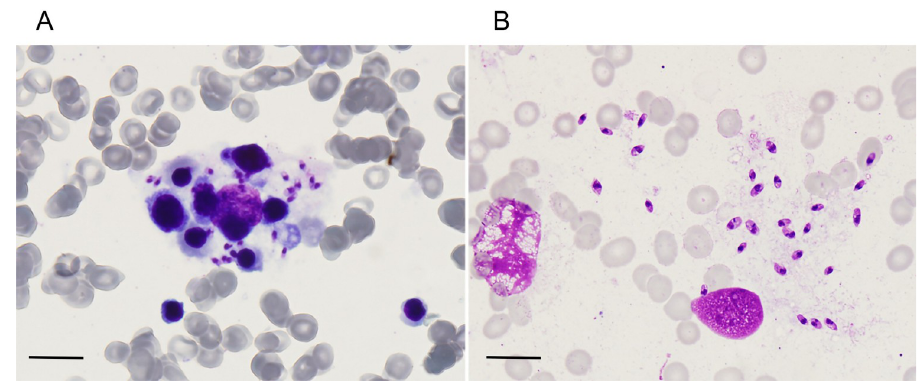
Fig 5. The bone marrow biopsy identified hemophagocytosis and Leishmania amastigotes in the VL associated HLH and VL patient. (A) Leishmania amastigotes was identified in bone marrow smear of VL associated HLH cases with polychromatic or orthochromatic erythroblasts and amastigotes inside under microscope. (B) Only Leishmania amastigotes was identified in the VL cases in the bone marrow smear (Giemsa stain, 100 × ). Scale bar, 10 μ